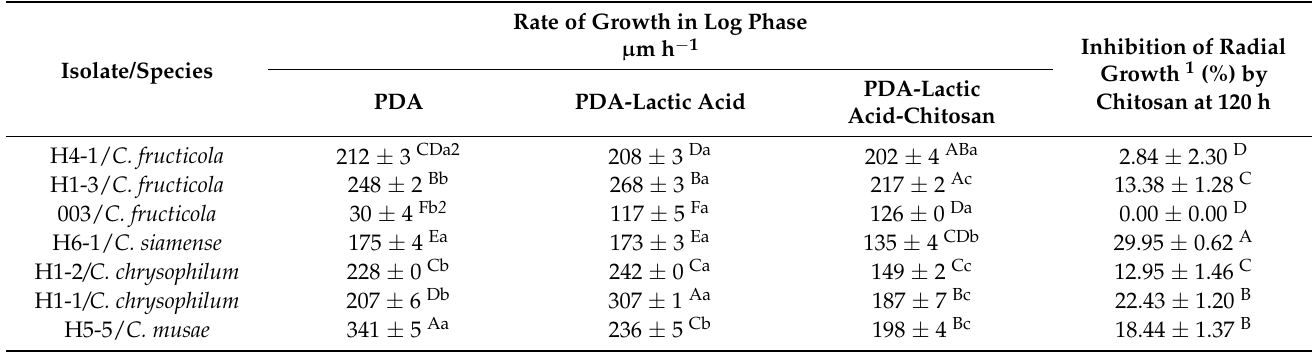
Table 1. Chitosan against Colletotrichum gloeosporioides complex species isolated from anthracnose of mango. Rate of growth during log phase and growth radial inhibition in medium PDA, PDA-lactic acid (0.05 M), and PDA-lactic acid (0.05 M) with 1 g L − 1 chitosan at 25 ◦